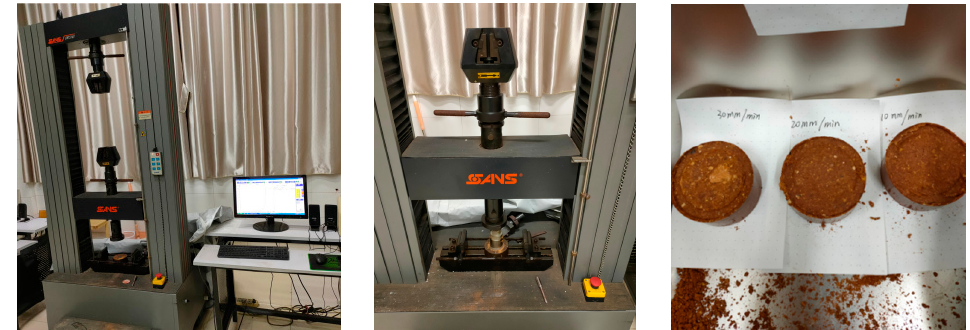
Figure 7. Compaction experiment of the soil.